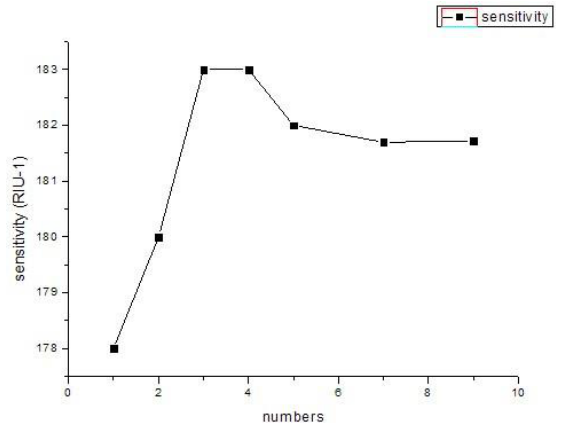
Figure 7. The relationship between the sensitivity and different numbers of PCFs filled with silver